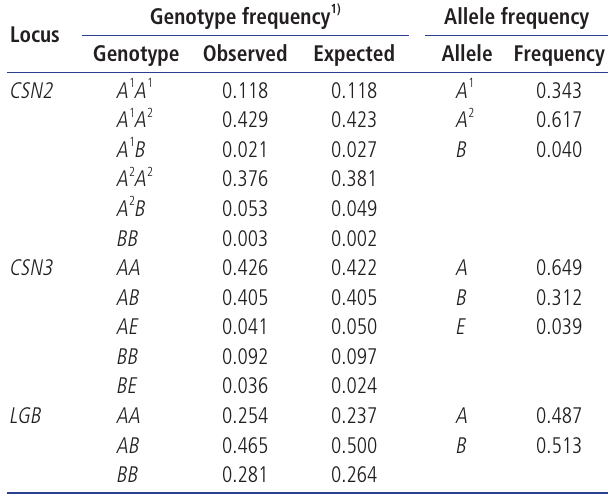
Table 2. Observed and expected genotype and allele frequencies for CSN2, CSN3, and LGB loci (n =